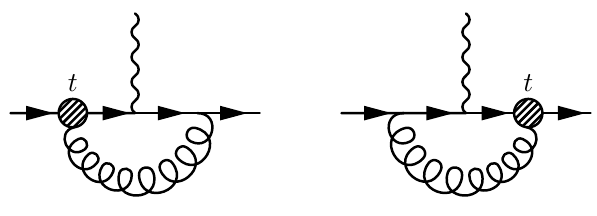
Figure 1 . Feynman diagrams for the matching calculation of the flowed qCEDM operator to the qEDM operator. The hatched blob denotes the insertion of the flowed qCEDM operator at flow time t